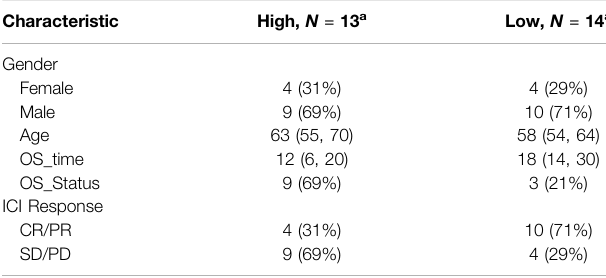
TABLE 2 | Characteristics of patients in low- and high-risk scores in GSE78220 cohort. Characteristic